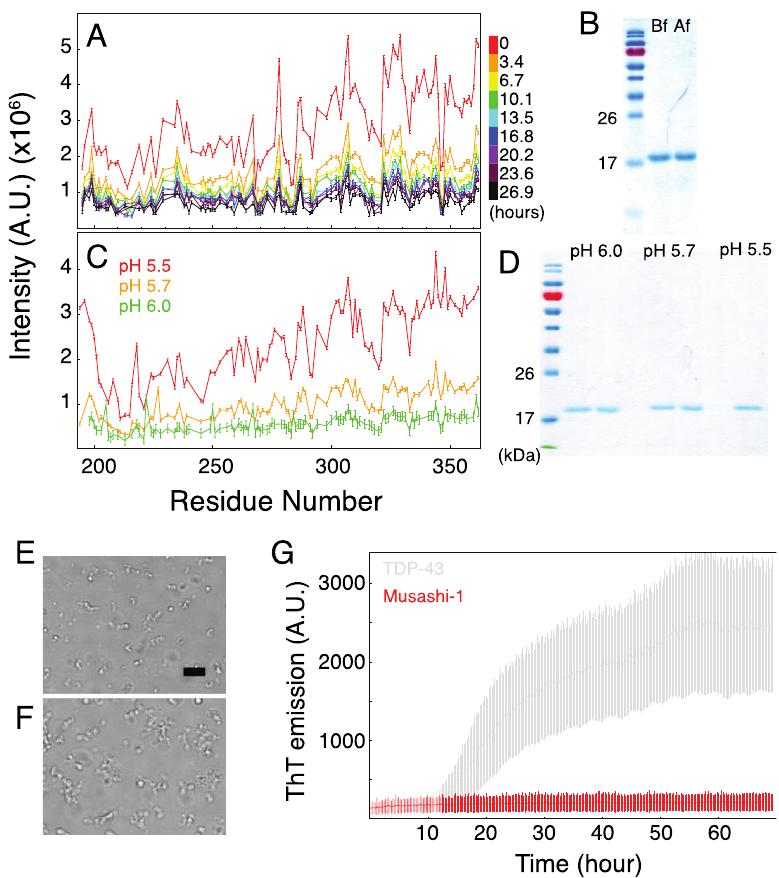
Figure 4. Analysis of the non-cross-beta Musashi-1 oligomers formed at lower pHs and after prolonged incubation. ( A ) Decrease in NMR HSQC peak intensity as a function of time. Data collected at 303 K, pH 5.5. ( B ) SDS-PAGE analysis of protein integrity before (Bf) and after (Af) the one-day NMR experiments, whose results are shown in panel A. ( C ) NMR HSQC peak intensities at 283 K and pH 5.5, 5.7, and 6.0 and 283 K. ( D ) SDS-PAGE analyses of the samples prepared at pH 5.5, 5.7, and 6.0. ( E,F ) Micrographs of samples ( E ) incubated at 303 K for 24 h at pH 5.5 or ( F ) freshly prepared at pH 6. Scale bar = 10 µ m. ( G ) ThT assay of Musashi-1 (red) and the C-terminal domain of TDP-43 (control experiment;